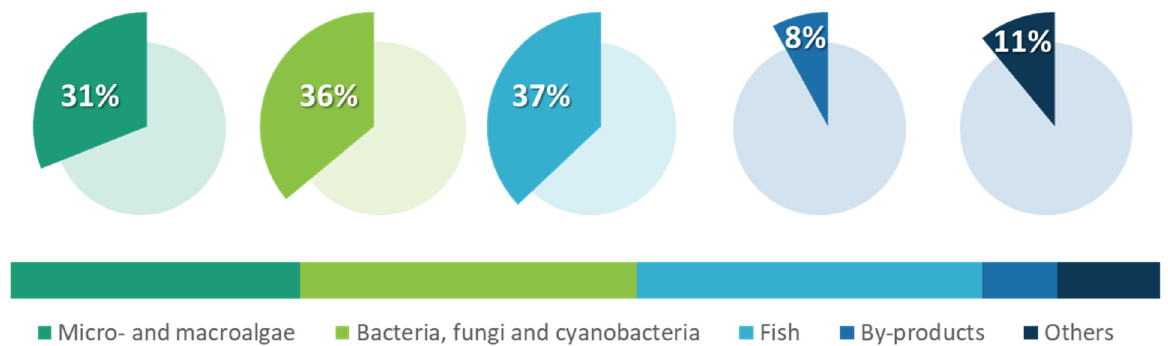
Figure 2. Distribution of the various biomasses used by Portuguese entities. It should be noted that a single entity can exploit multiple biomass sources. Adapted from the Blue Bioeconomy Roadmap for Portugal [30].